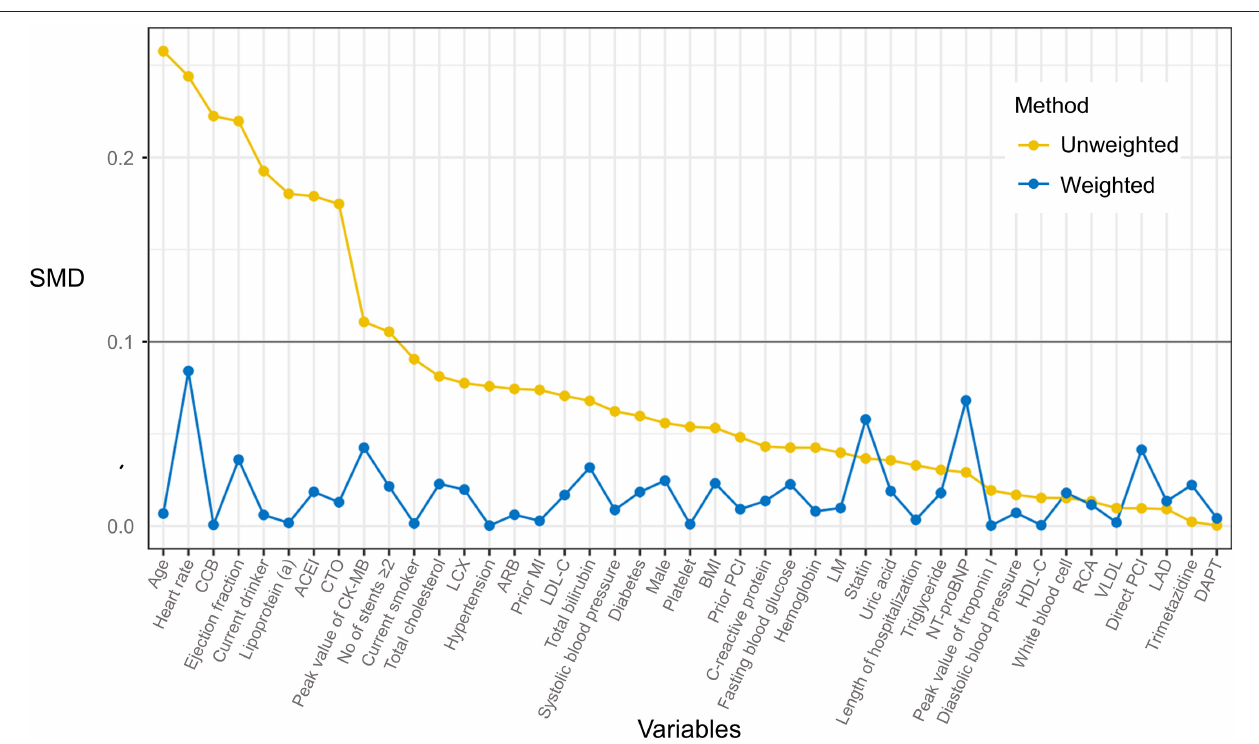
TABLE 3 | Treatment effect of metoprolol vs. observation during the 3 years following the PCI-related PMI in IPTW-adjusted population. Incidence rate % (events/patients) ARD RRD NNT RR Metoprolol Observation MACEs 15.0% (29.1/193.4) 22.1% (26.2/118.6) Cardiac death